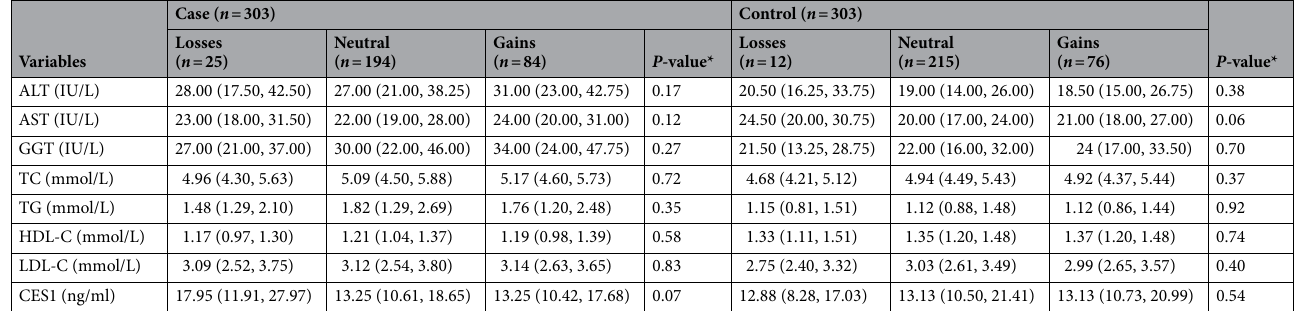
Table 3. Comparison of clinical data between the CNV status among the subjects, n (%) or medians (IQRs). CNVs, copy number variation; IQR, interquartile range; ALT, alanine aminotransferase; AST, aspartate aminotransferase; GGT, gamma-glutamyltransferase; TC, total cholesterol; TG, triglycerides; HDL-C, high-density lipoprotein cholesterol; LDL-C, low-density lipoprotein cholesterol; CES1, carboxylesterase 1. * P -values were calculated by using the Chi-square test for categorical variables and Kruskal Wallis test for continues